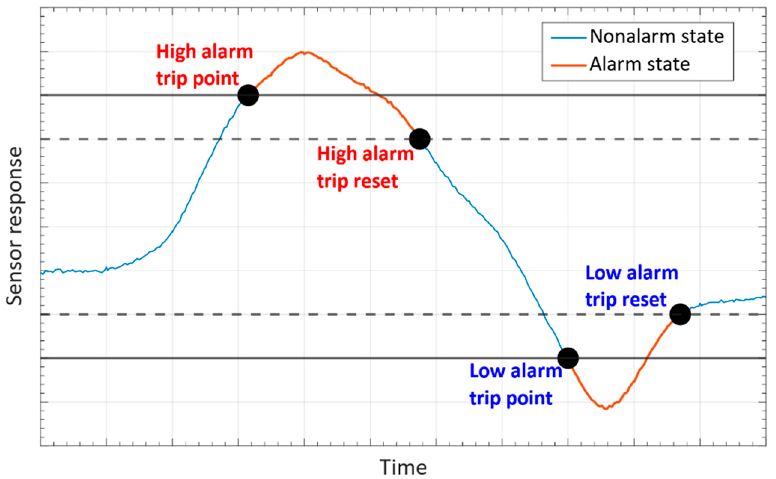
Figure 1. Example of limit alarm trip implementation considering the time behavior of a generic sensor’s output.